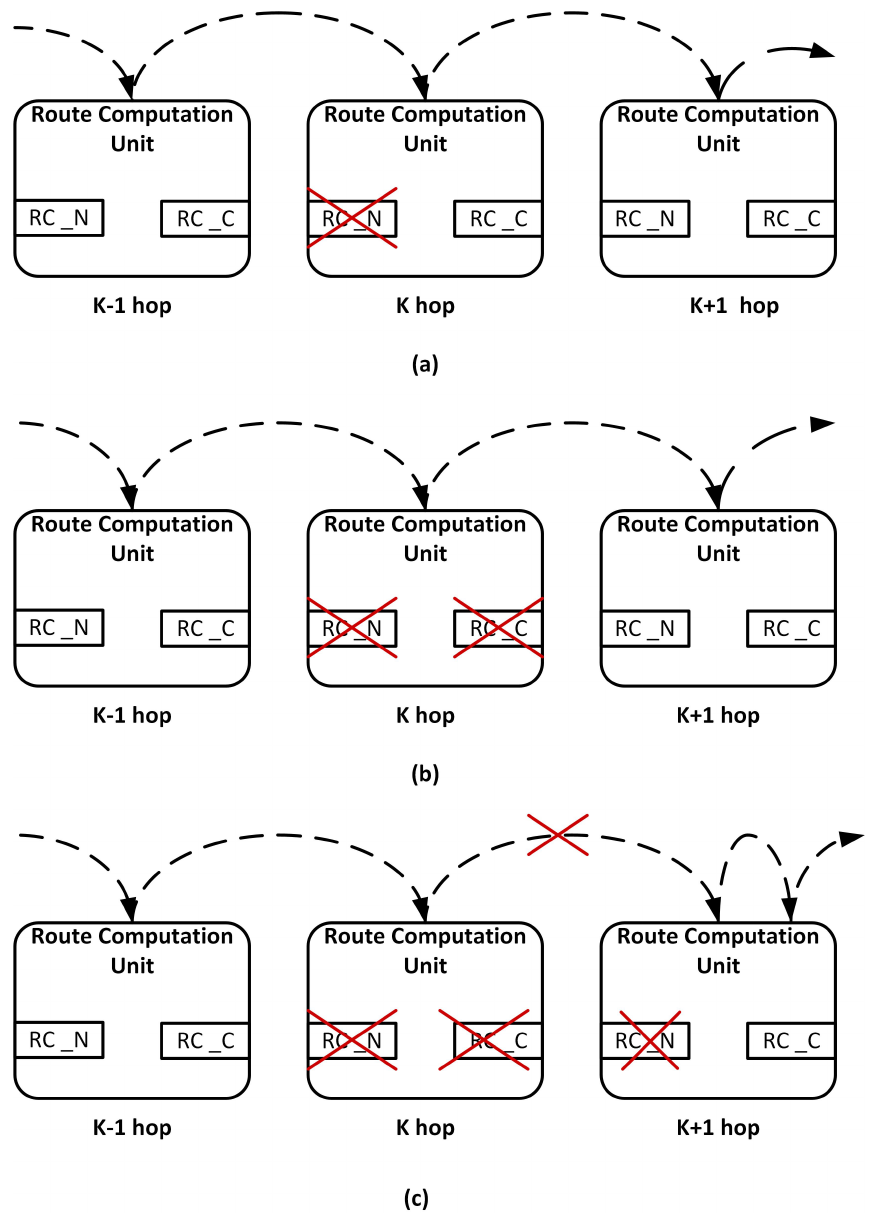
Figure 4. Route computation (RC) fault-tolerant design: ( a ) scenario 1 where RC_N is faulty, ( b ) scenario 2 where both RCs are faulty, and ( c ) scenario 3 where both RCs of the current and RC_N of downstream router are